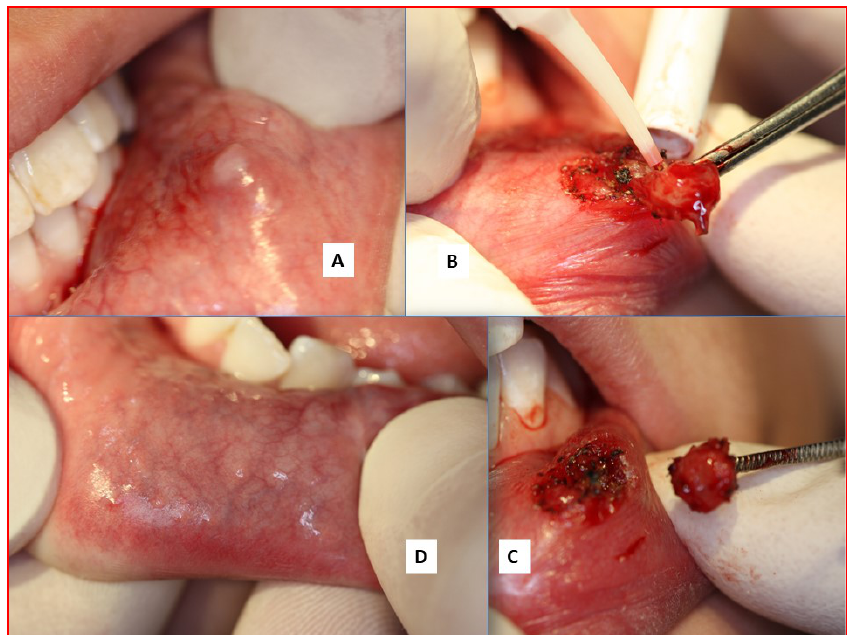
Figure 7. Soft tissue surgery. A mucocele excision, lower lip. The laser used was a diode 980 nm 1.25W CW Fluence 12.2 J / cm 2 . Time taken: two minutes with pauses. A—pre-op, B—excision with haemostasis, C—immediate post-op, D—healing at one month. Table 3. Common natural and man-made fluorophores that may be met within clinical dentistry. “Overlapping” excitation—for example, that found in porphyrins as an original component of blood haemoglobin but also a by-product contaminant of dental plaque, calculus and caries, and also tooth discolourations. Source: Original graphics S. Parker. Data reproduced with thanks: Kim, A; Roy, M; Dadani, FN; Wilson, BC; Topographic mapping of subsurface fluorescent structures in tissue